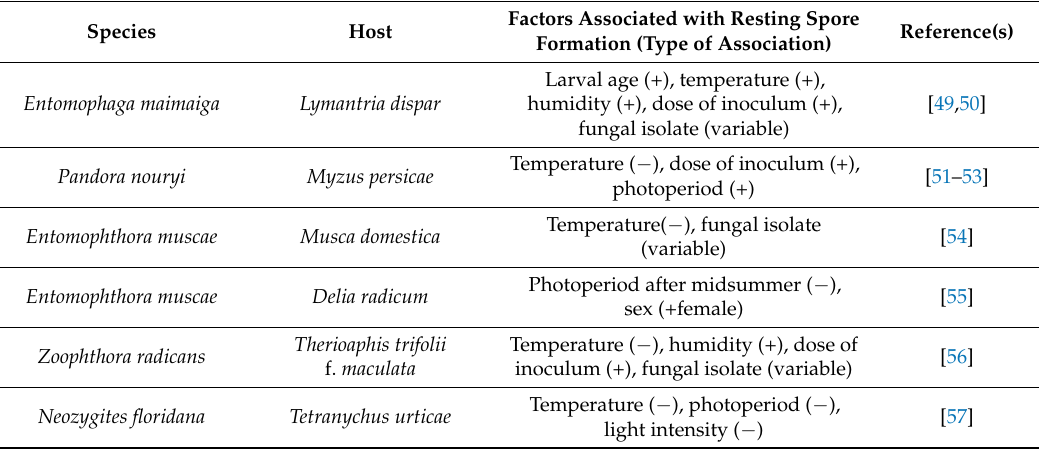
Table 2. Conditions associated with formation of resting spores in arthropod